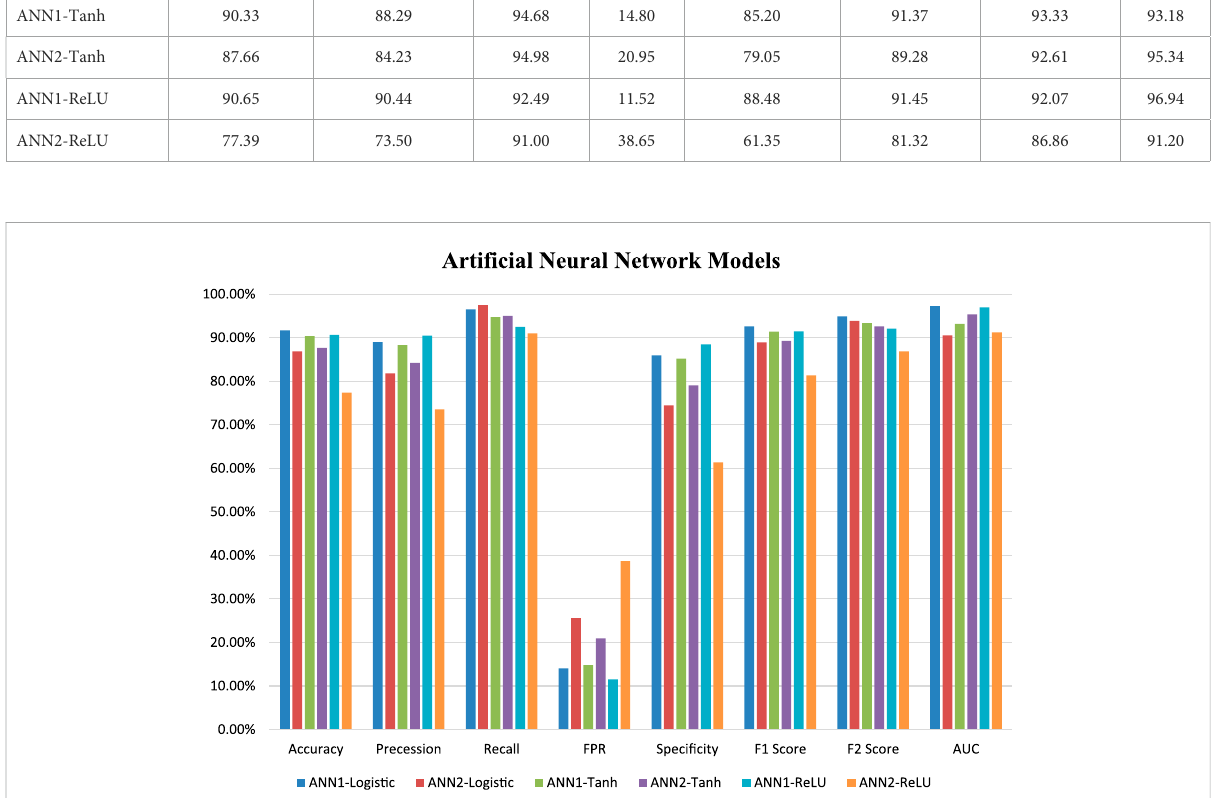
FIGURE 1 Graphical representation of six ANN model ’ s performance based on a different statistical